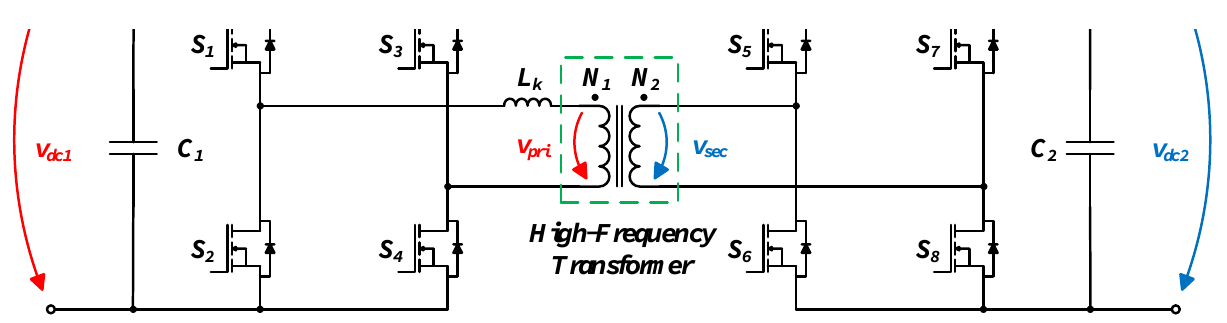
Figure 1. Dual active bridge (DAB)